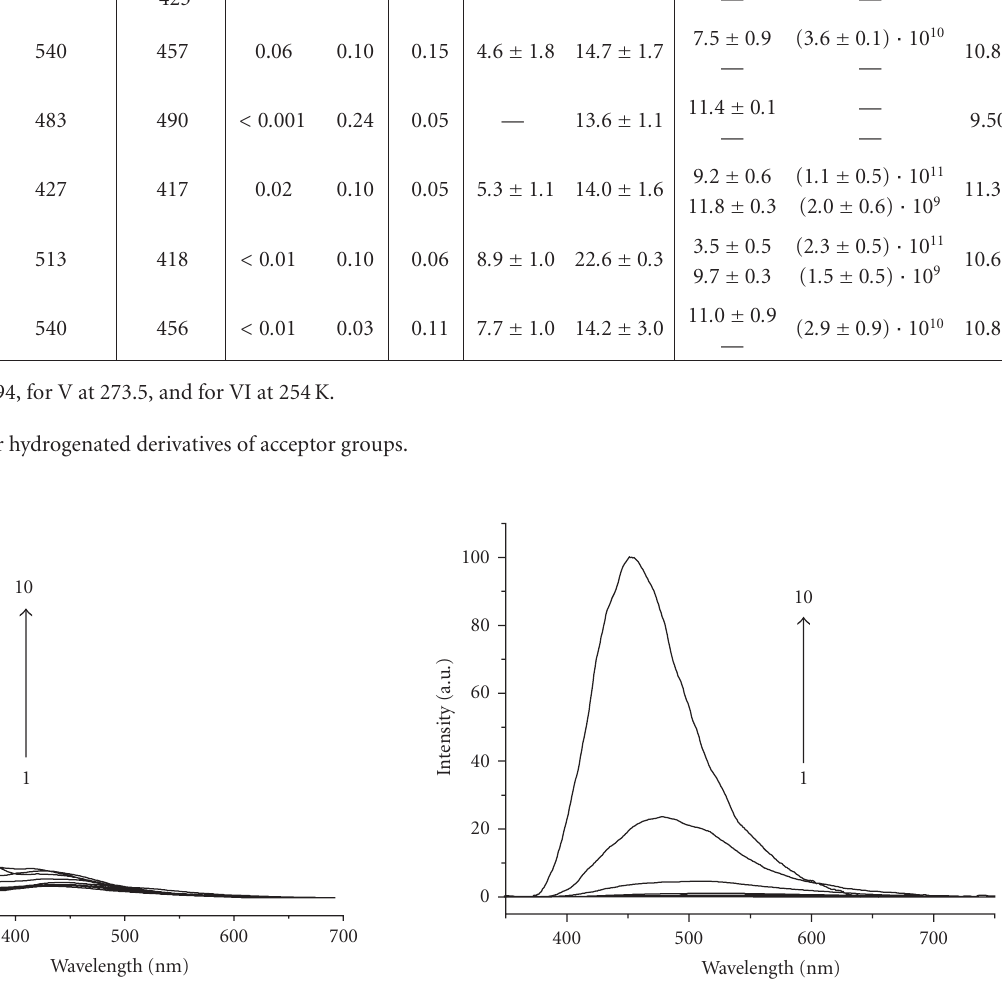
medium viscosity to the inhibition of the process is also supported by the behavior of the fluorescence spectra of the samples in PMMA at 293 K. At these conditions, only LE bands are present, while CT bands completely disap- pear. The fluorescence spectra positions of I, II, IV–VI in PMMA and heptane are close. The spectral position of III fluorescence in PMMA is blue shifted by 66 nm with re- spect to heptane. A peculiarity of the compounds stud- ied is the appearance of the phosphorescence observed at 77 K for I–VI in ethanol and butyronitrile glass matrix (Table